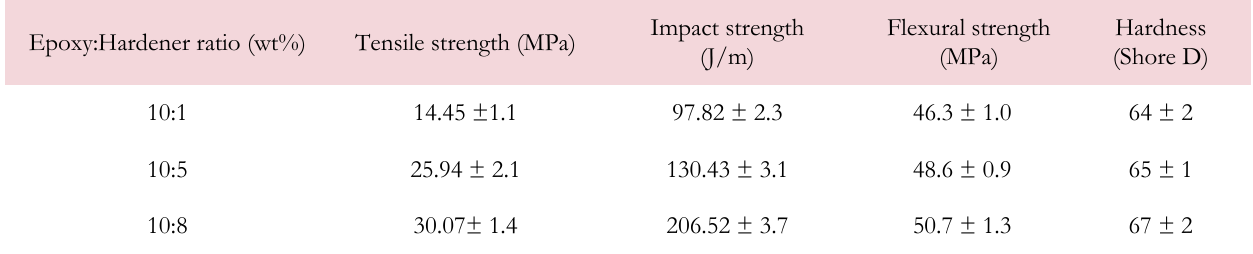
Table 2: Mechanical properties of composites at different epoxy: hardener ratio